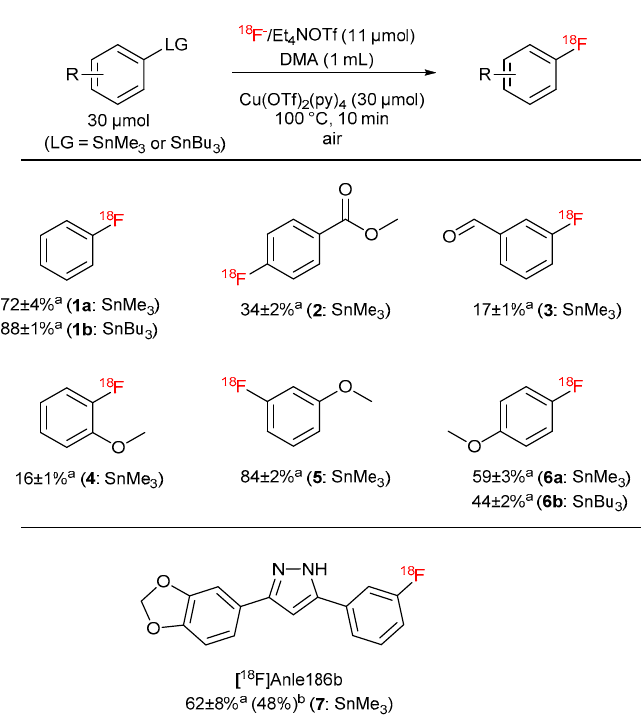
Figure 11. Substrate scope of the optimized protocol for 18 F-fluorodestannylation. a RCC ± SD. b RCY, single experiment was carried out.